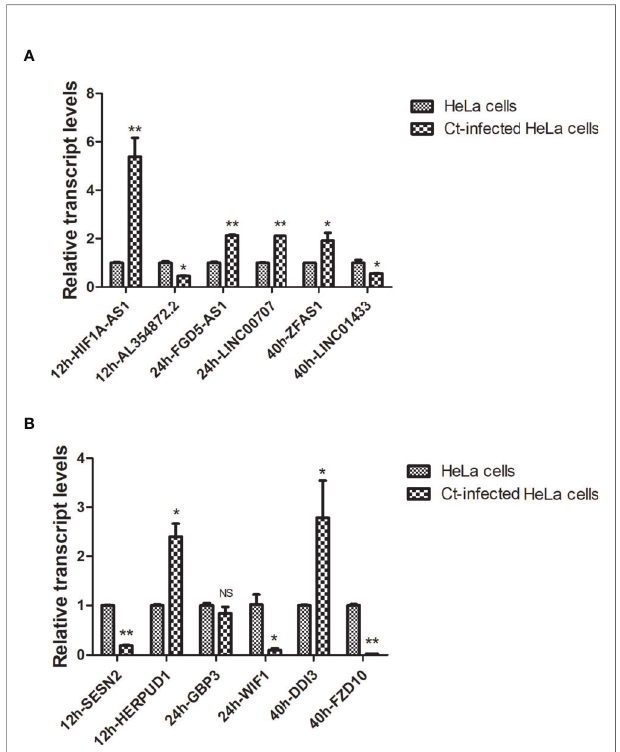
FIGURE 4 | RT-qPCR validation of host differentially expressed lncRNAs and mRNAs in Ct-infected HeLa cells and uninfected cells. The relative transcriptional levels of six differentially expressed lncRNAs (A) and six differentially expressed mRNAs (B) at different post-infected hours in Ct- infected HeLa cells and uninfected cells were detected using RT-qPCR. The results were normalized with the endogenous 18S rRNA control and measured the relative amount of target gene. Each sample was run in triplicate to ensure accurate fold change estimation, and the results were expressed as mean±SD. * P <0.05; ** P <0.01; NS, no signi fi